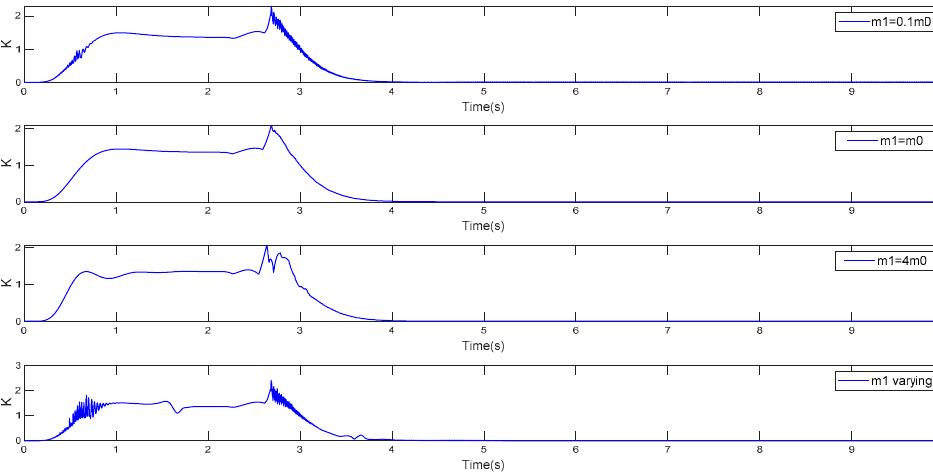
κ Figure 9. Gain of the SM term during the robustness test. Figure 9. Gain κ of the SM term during the robustness